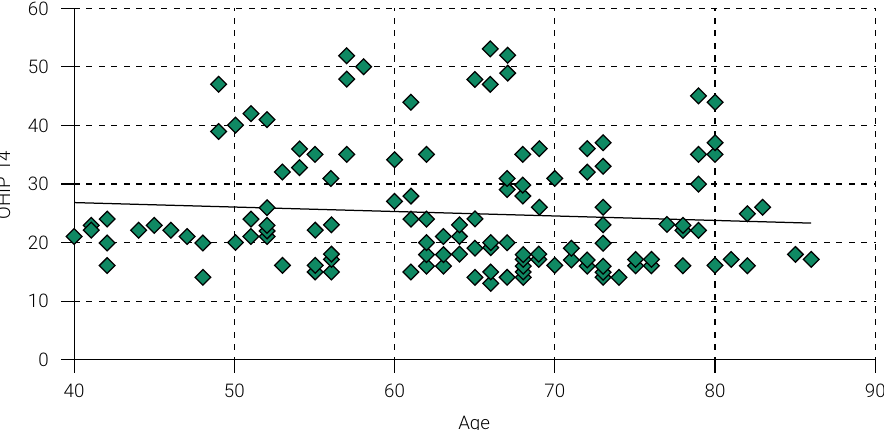
Regarding the OHRQoL index (OHIP-14), each answer was registered on a Likert scale (minimum score of 1 and maximum of 5) (Fig.